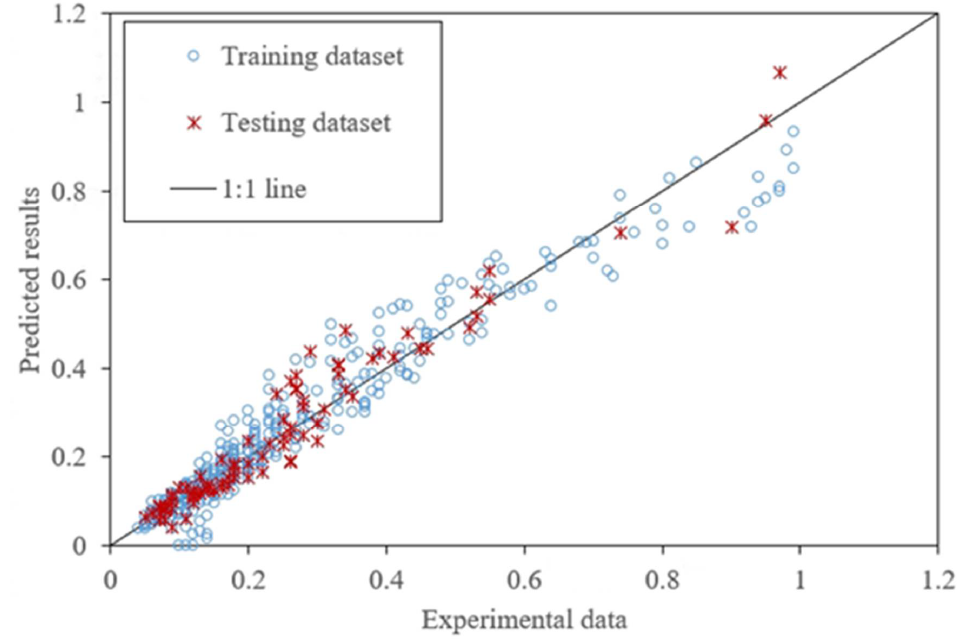
Table 1. Performance indices for the ANFIS model predictions.